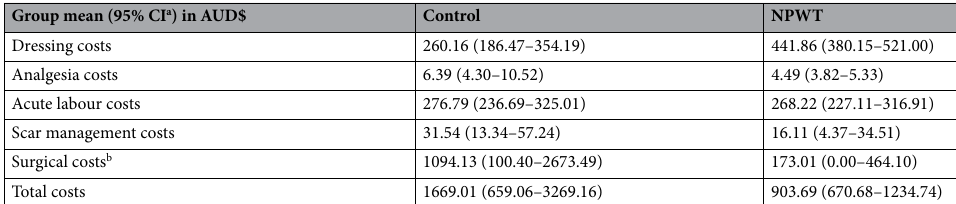
Table 2. Clinical costs for each treatment group. a 95% CI derived from bootstrap resampling (2000 replications) to represent distribution uncertainty. b Including grafting and dressing changes under general anaesthetic for patients who underwent a theatre